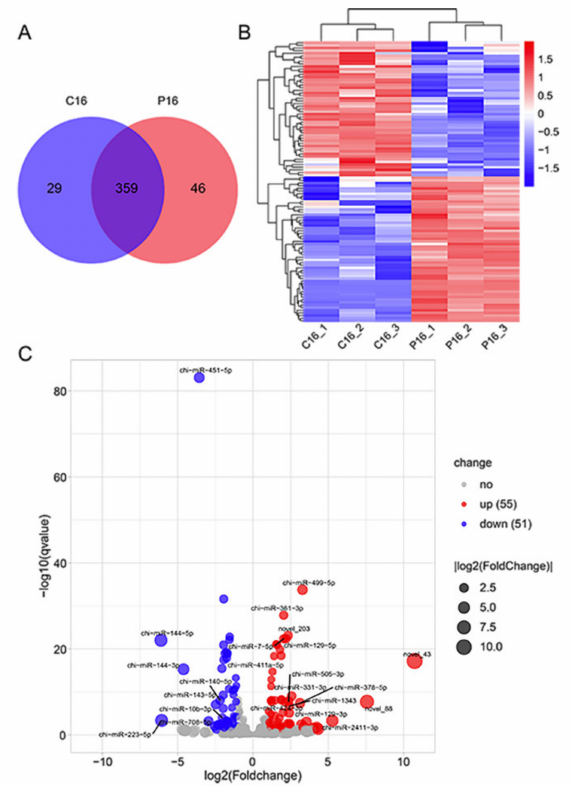
Figure 3. Overall differences of miRNAs in pregnant and non-pregnant state. ( A ) The Venn diagram shows the differential expression of miRNAs. ( B ) Heatmap shows the expression patterns of miRNAs between C16 and P16. ( C ) The volcano plots of the differentially expressed miRNAs on P16 and C16. Legend: C16, on day 16 of the estrous cycle; P16, on day 16 of pregnancy.